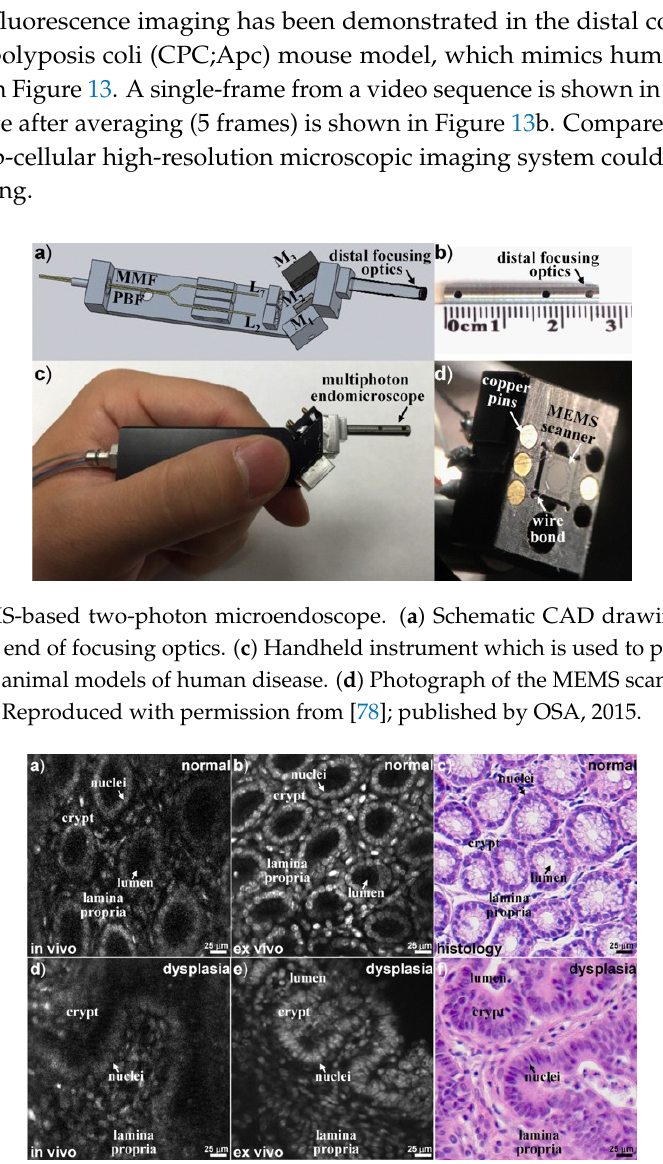
Figure 13. Fluorescent imaging results using the MEMS-based two-photon microendoscope. ( a ) Two-photon excited fluorescence image of normal colonic mucosa. ( b ) In-vivo image from normal averaged over five frames. ( c ) Corresponding histology of normal colon. Single frame from video of dysplastic crypts from colon of CPC; adenomatosis polyposis coli (Apc) mouse ( d ) In vivo at 5 frames/sec and ( e ) In vivo image (averaged over five frames). ( f ) Corresponding histology of dysplasia. Reproduced with permission from [78]; published by OSA, 2015.